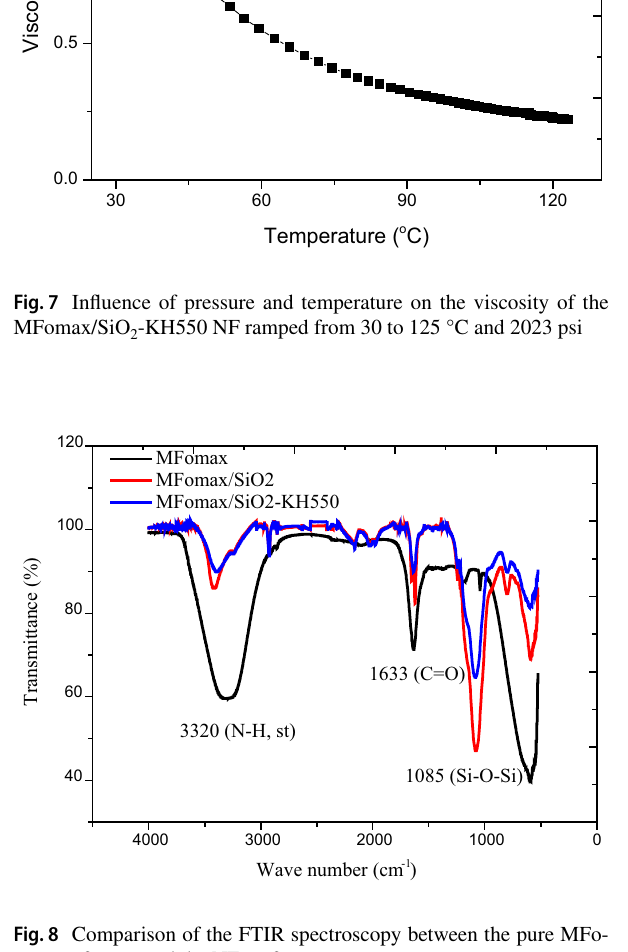
Fig. 8 Comparison of the FTIR spectroscopy between the pure MFo- max surfactant and the NF